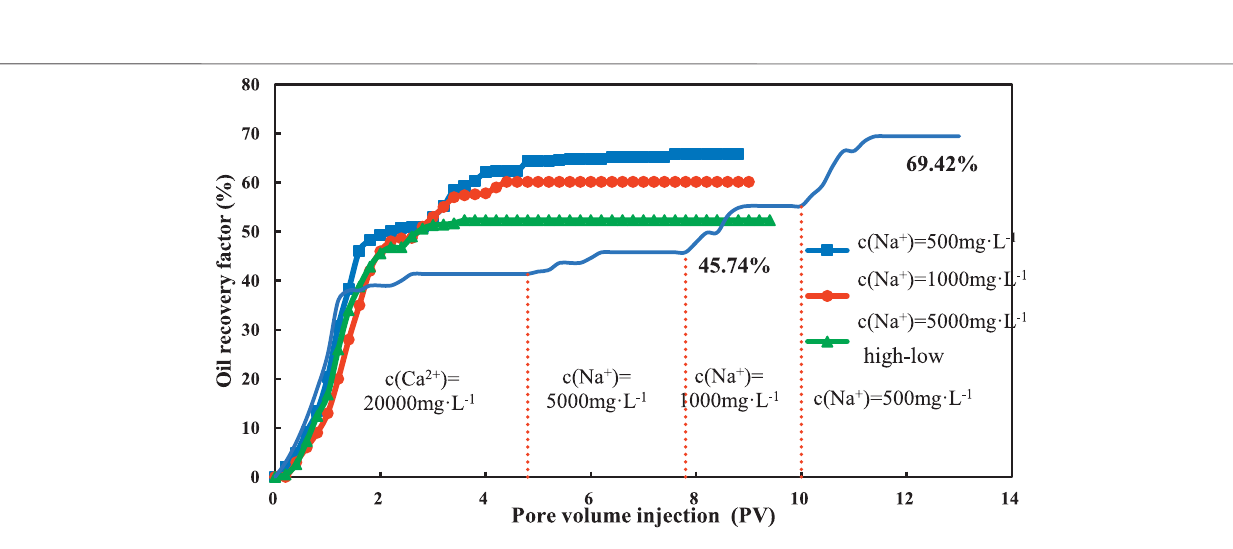
Frontiers in Energy Research |